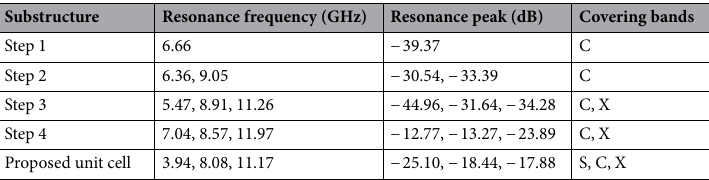
Table 2. Transmission Coefficient (S 21 ) of successive steps for the proposed unit cell.